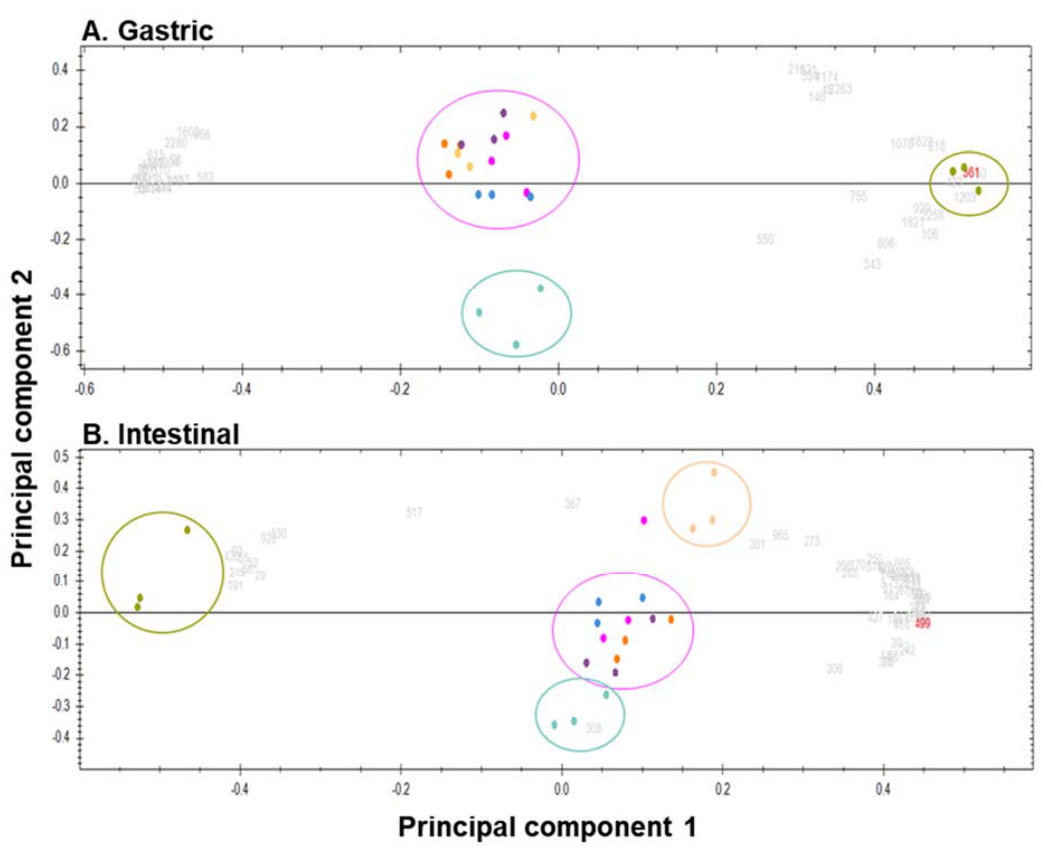
Figure 5. Principal component analysis of the most relevant identified peptides detected at the end of the gastric ( A ) and intestinal ( B ) phases of the SGID: grey and red numbers correspond to the identified peptide displaying a mass signal intensity > to 1 × 10 5 and an ANOVA p -value < 0.005. Color circles are hand-marked to facilitate understanding and have no statistical significance. C1, purple; C2, dark orange; C2 low Ca2+, light orange; C3, light blue; CW, dark blue; W, green; and QC, pink.